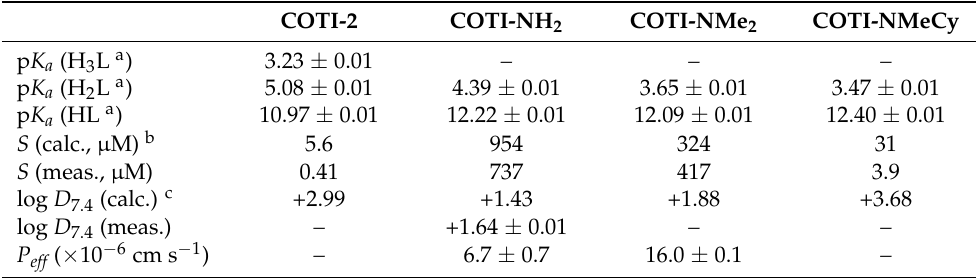
Table 1. p K a values determined by UV-vis spectrophotometric titrations in 30% ( v/v ) DMSO/H 2 O ( I = 0.1 M (KCl)); measured and predicted solubility ( S ), log D 7.4 ( n -octanol/water), and effective passive permeability ( P eff ) values at 25 ◦